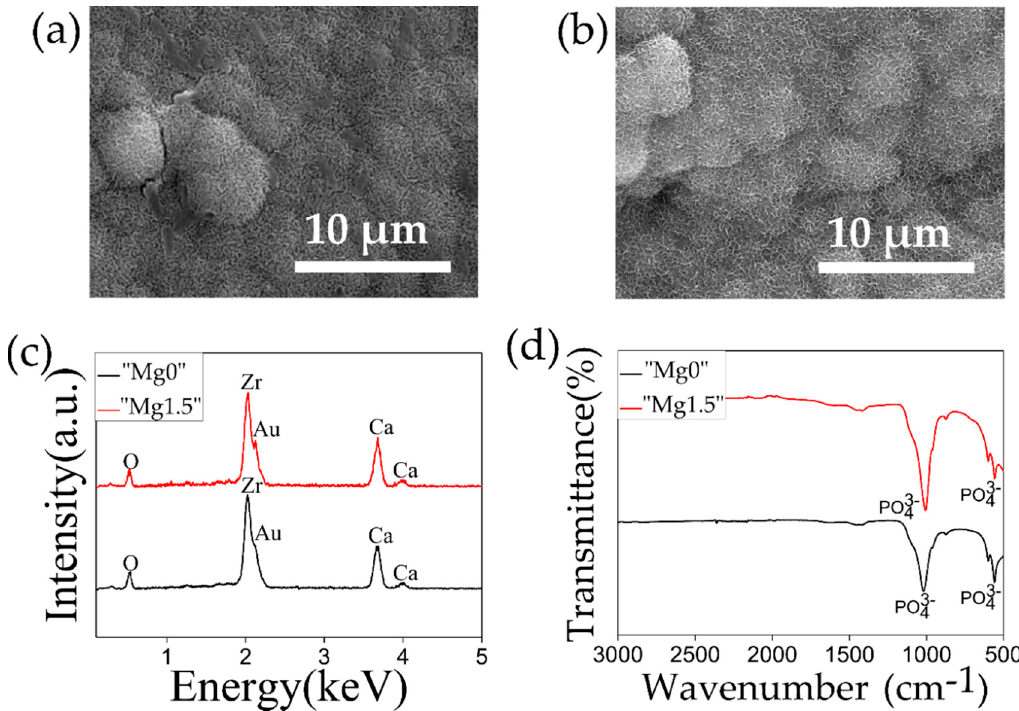
Figure 5. SEM images of ( a ) “Mg0” solution and ( b ) “Mg1.5” solution-treated 3Y-TZP samples after 1 day SBF immersion. ( c ) EDX and ( d ) FTIR plots comparing properties of “Mg0” solution and “Mg1.5” solution-treated 3Y-TZP samples after 1 day SBF immersion.